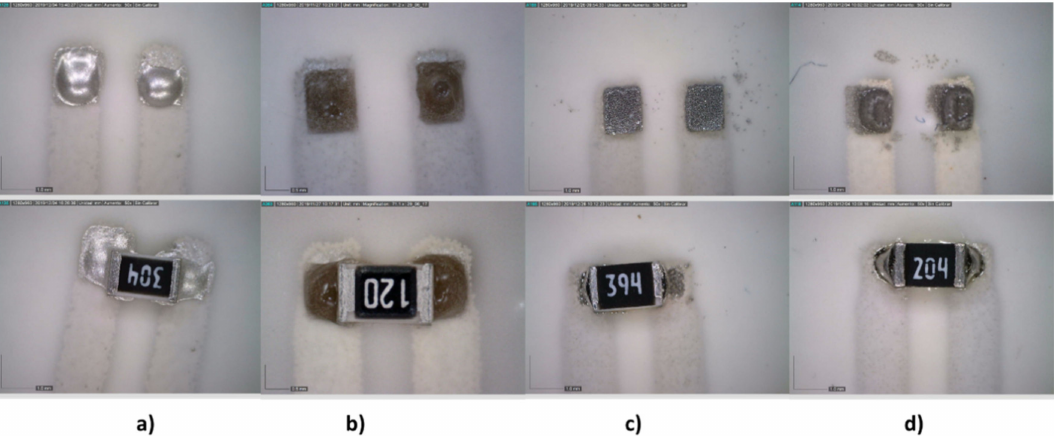
Figure 14. Stencil printing of pastes/adhesives on wave reflow footprint. Above: after printing; below: after temperature curing. ( a ) Inkron IPC-603X, ( b ) DELO MONOPOX AC245, ( c ) NC-SMQ80/1E, and ( d ) Voltera T4/T5.